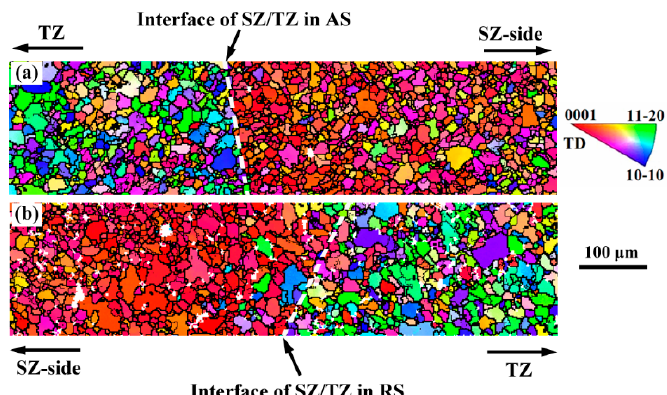
Figure 3. EBSD orientation maps of the SZ/TZ interfaces in FSW AZ31 alloy: ( a ) AS; and ( b ) RS [92].